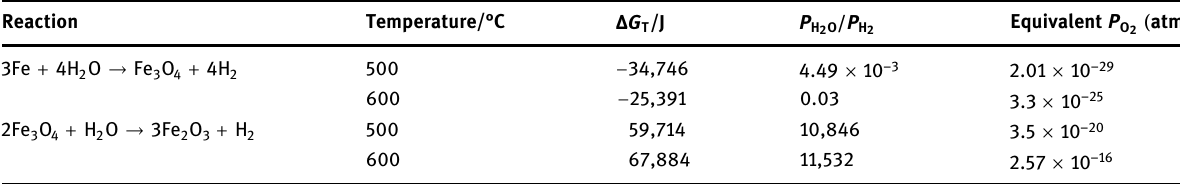
Table 4: Thermodynamic data of reaction ( 10 ) and ( 12 ) at 500 and 600°C